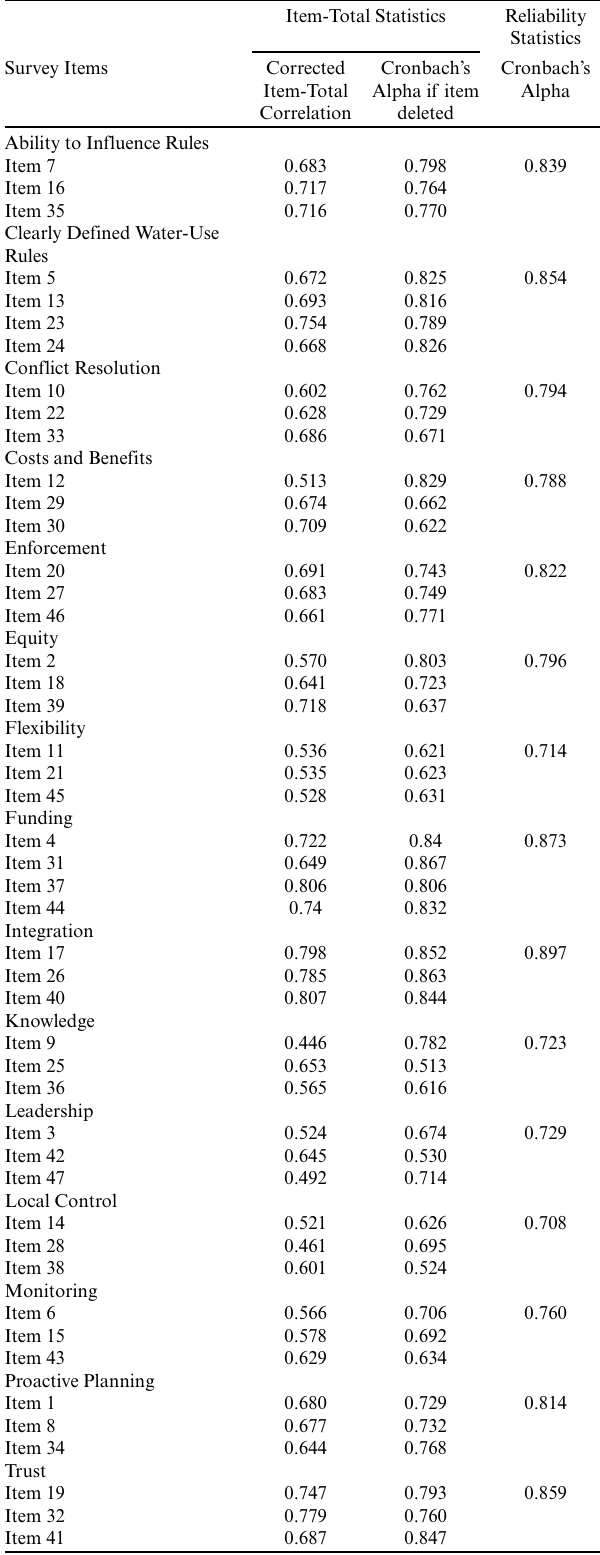
Table 2 . Scale item reliability